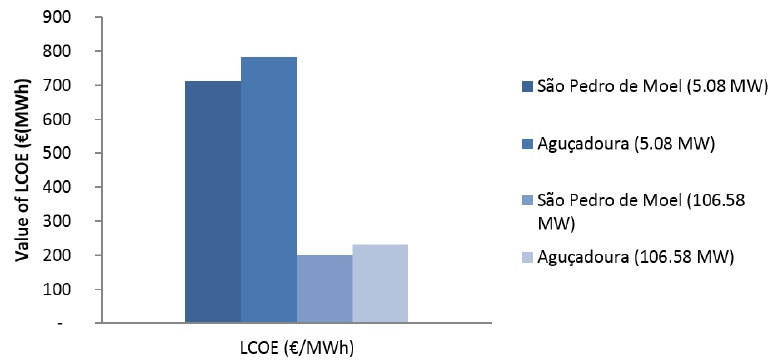
Figure 14. LCOE of several wave farms.